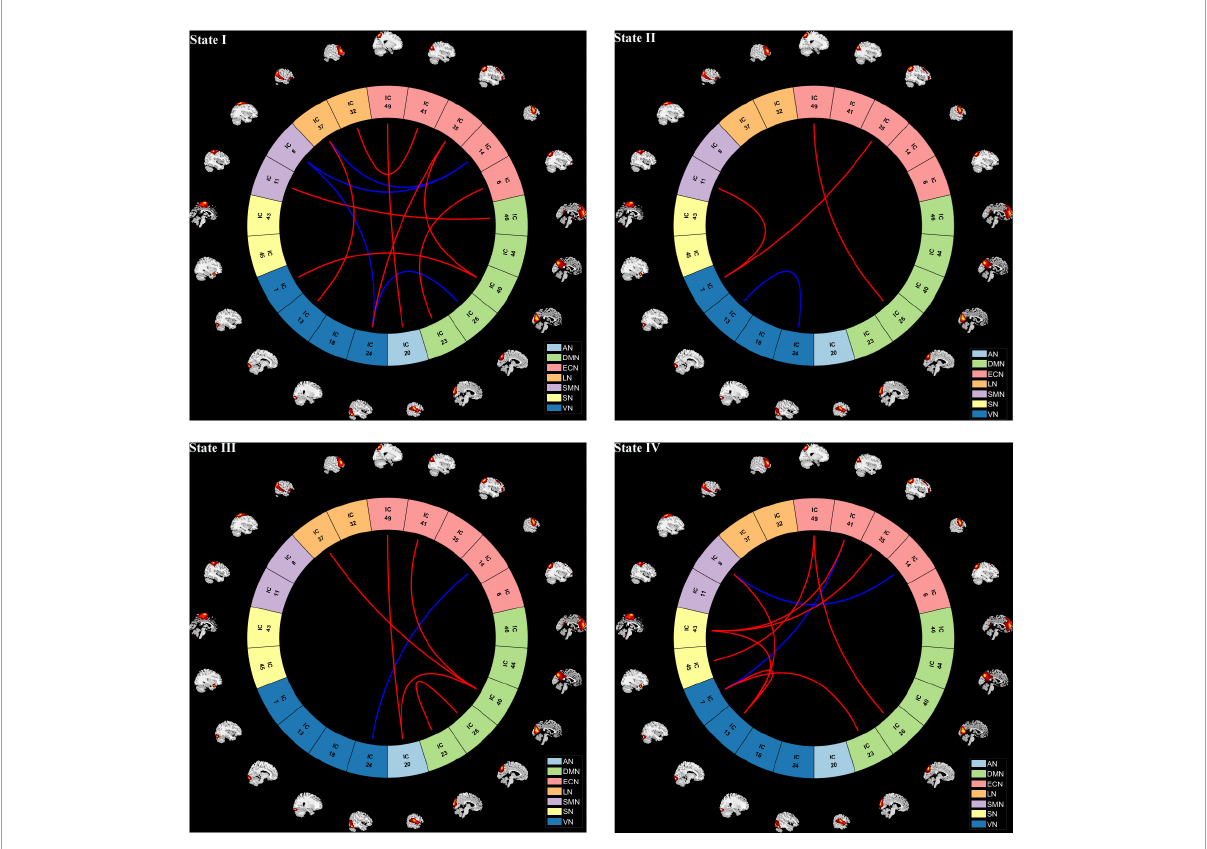
FIGURE5 The visualization of dynamic functional network connection intensity differences in each state. Red line indicates higher functional connection strength in COPD compared to HC group, while the blue line represents reduction. AN, auditory network; DMN, default mode network; ECN, executive control network; LN, language network; SMN, sensorimotor network; SN, salience network; VN, visual